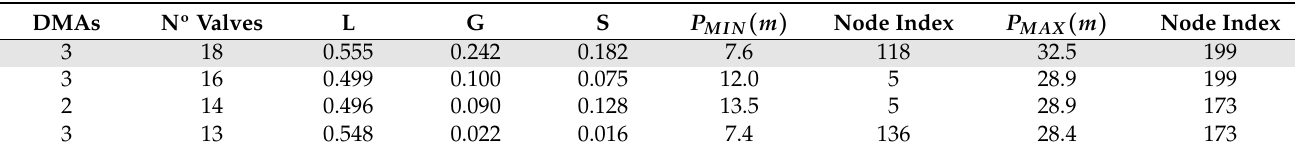
Table 2. Operating conditions of each solution obtained with Gini coefficient for TRN network. The gray background corresponds to the solution B represented in Figure 6. DMAs